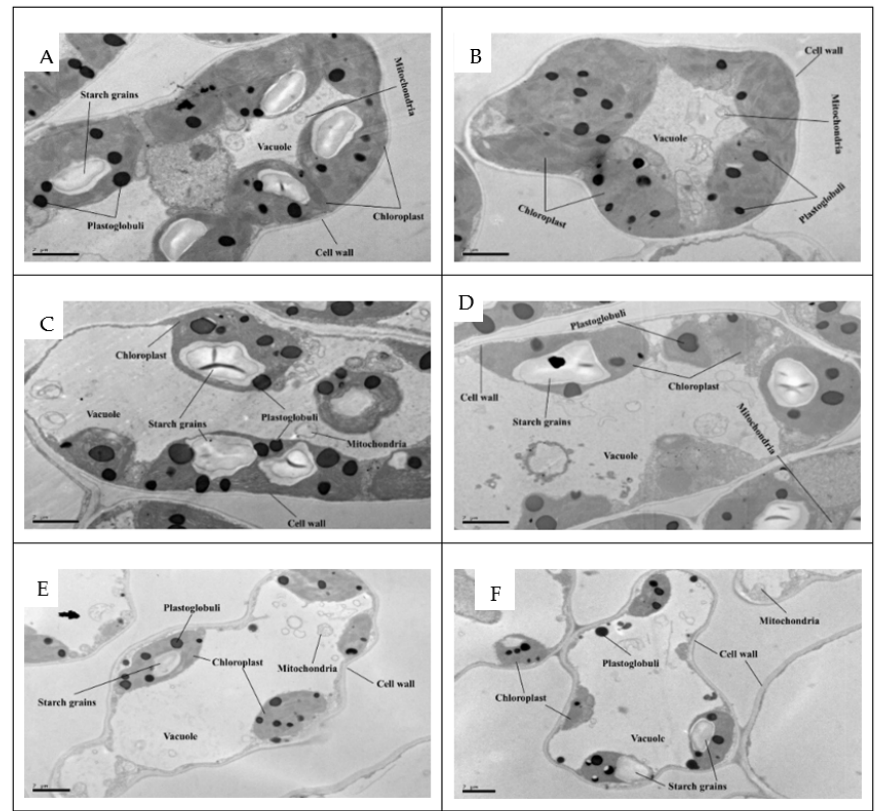
Figure 5. Transmission electron microscopic photos of C. capsularis seedlings leaf cells. Different lowercase values used in these photos are as follows: ( a ) control (10,000) ( b ) EDTA (10,000) ( c ) 50-μM/L Cu (10,000) ( d ) 50-μM/L Cu + 3-mM EDTA (10,000) ( e ) 100-μM/L Cu (10,000) ( f ) 100-μM/L Cu + 3-mM EDTA (10,000).